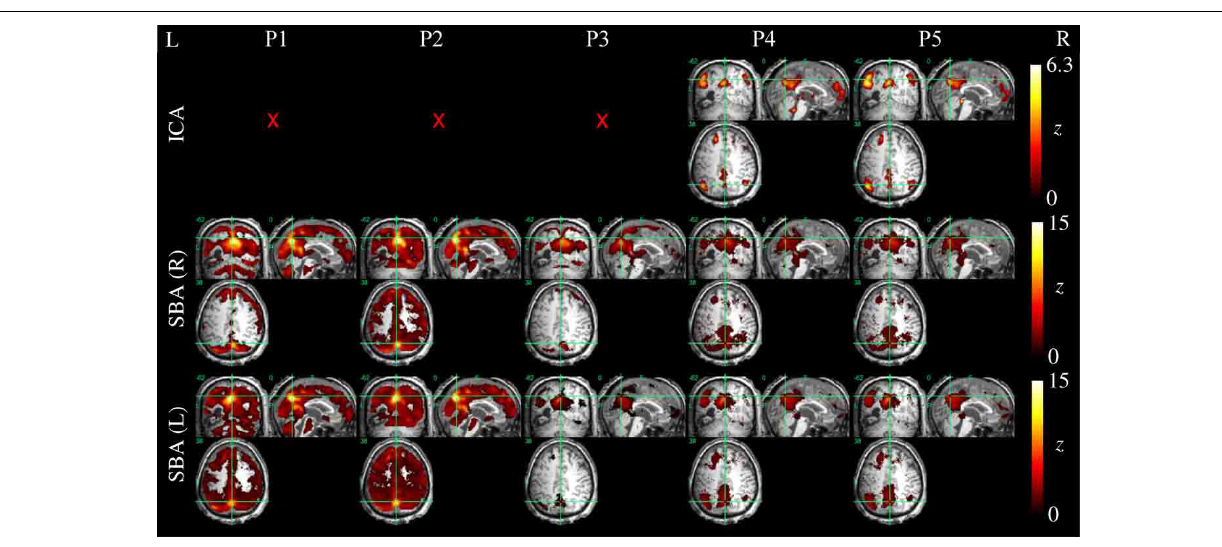
FIGURE 9 | DMN functional connectivity maps computed with ICA (top row) and SBA (middle and bottom rows) for a patient with a clinical diagnosis of minimally-conscious state (maximum movement 5.0mm, 24/200 outlier volumes); red crosses denote inability to identify DMN activity in any of the 20 components extracted by ICA. Here, applying procedures 4 and 5 made ICA decomposition capable of revealing coherent